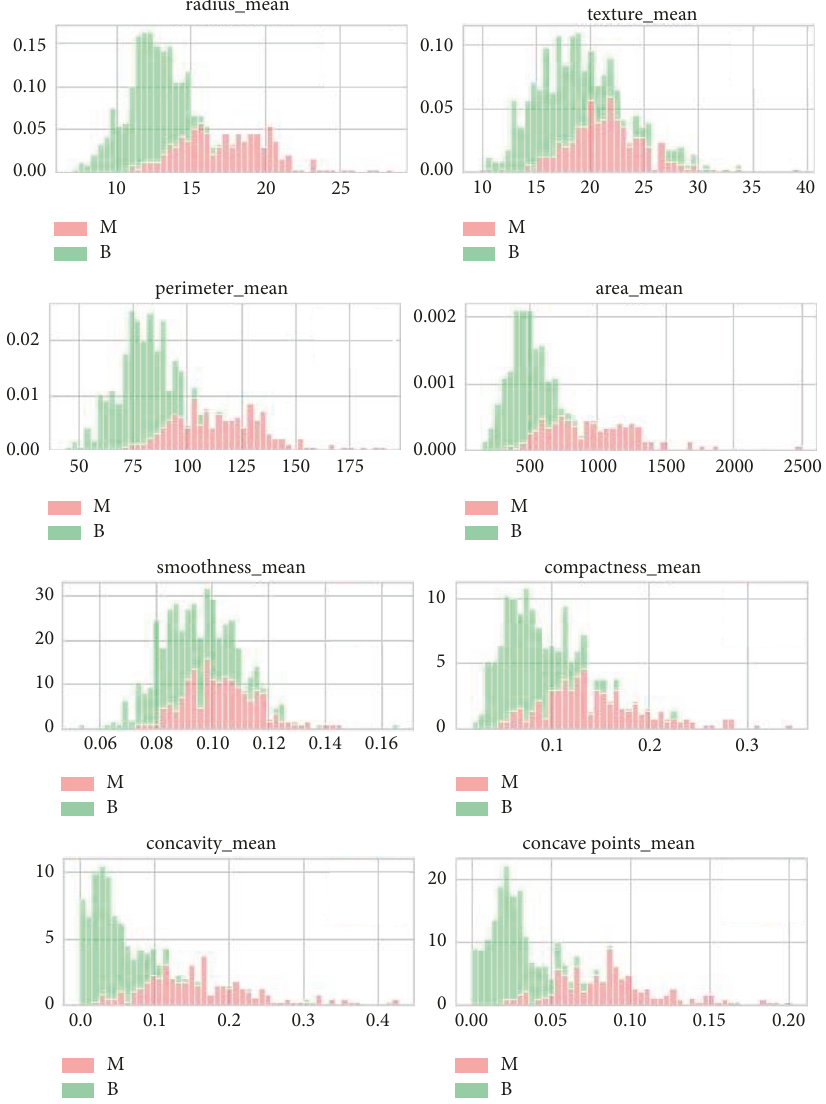
Figure 3: Prediction values shown by the